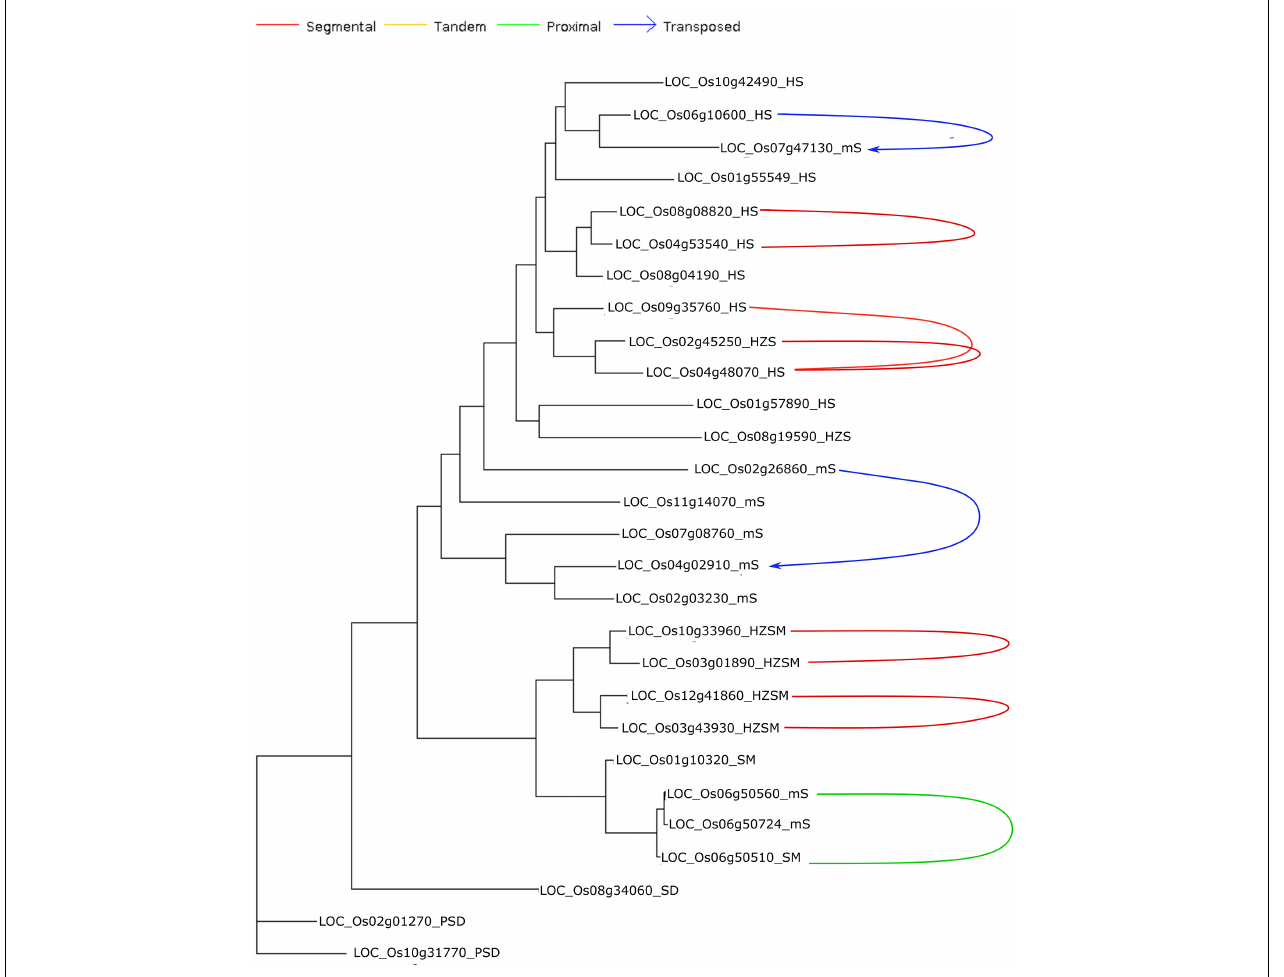
FIGURE 5 | Phylogenetic tree of the Oryza sativa var. japonica START genes family annotated with different modes of gene